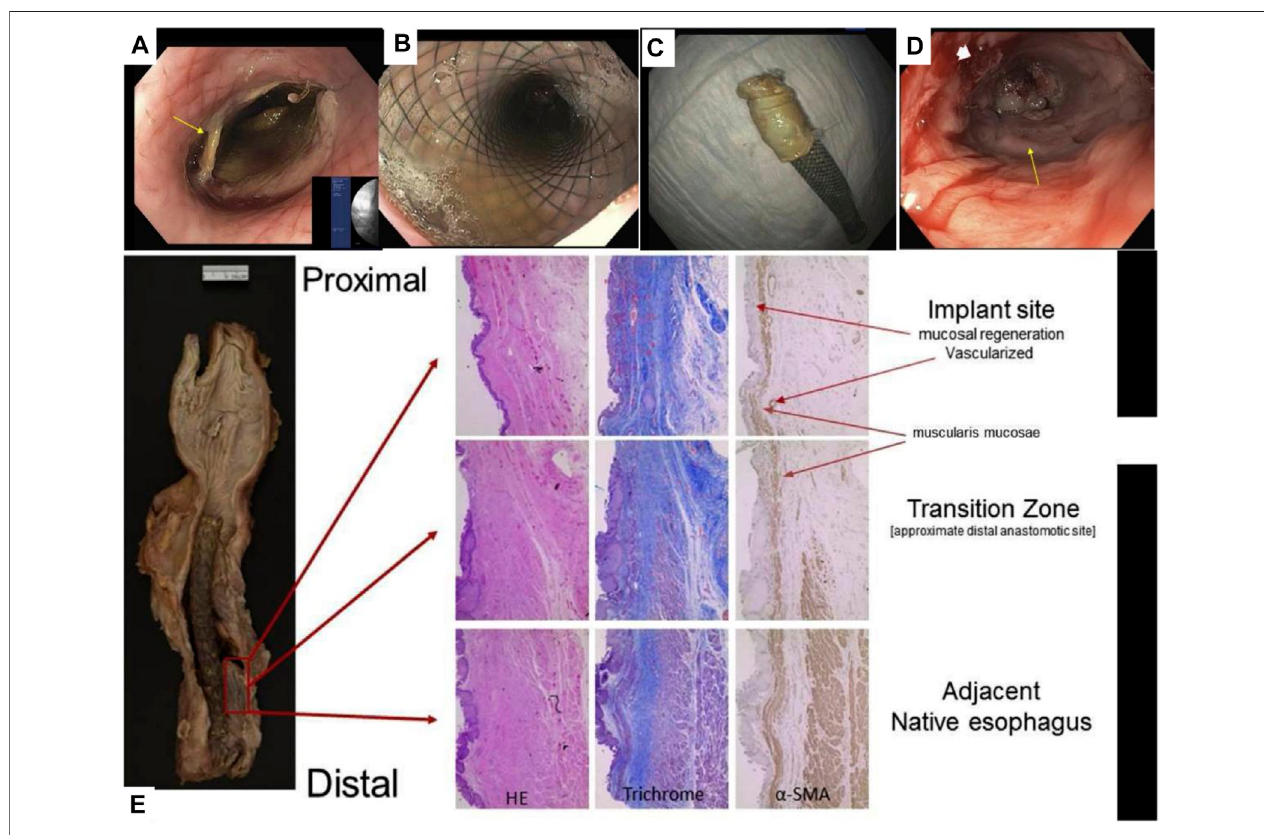
FIGURE3| PUcombinedwithMSCsforreconstructionofthehumanesophagus. (A) EGDimageoftheesophagusafterscaffoldplacement. (B) EGDimageofthe esophagusafterscaffolddeployment. (C) TheremovedCEIscaffoldassemblyisadheredtothescaffold. (D) EGDimageofesophagealneoplastictissue. (E) Histological examination of esophageal sections, including H&E staining, Masson staining, and immunohistochemical staining to detect the expression of α -SMA (Aho et al., 2021).